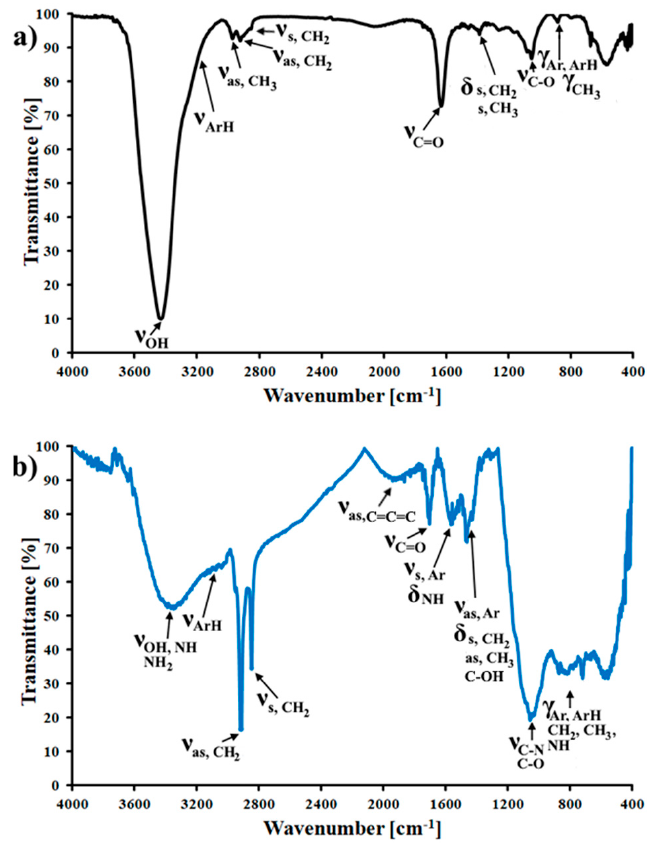
Figure 5. FT ‐ IR spectra of ( a ) CMK ‐ 3 and ( b ) N ‐ CMK ‐